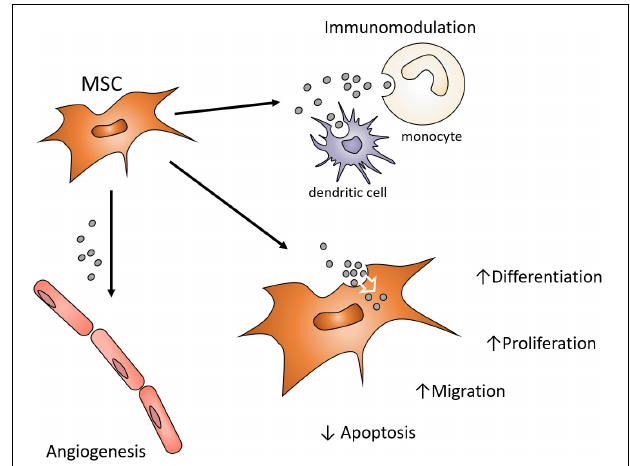
FIGURE 1 | Possible MSC exosome functions contributions to paracrine signaling in Bone Regeneration. MSC exosomes endocytosed by various local cells can influence angiogenesis, inflammation and the functions of osteoprogenitor cells. Enhancing functions of endogenous cell types involved in craniofacial regeneration avoids the harvesting, expansion and use of autogenous or allogenic cells. Exosomes can provide alternative modulation of cell function to avoid use of growth factors or cytokines in order to alter target cell